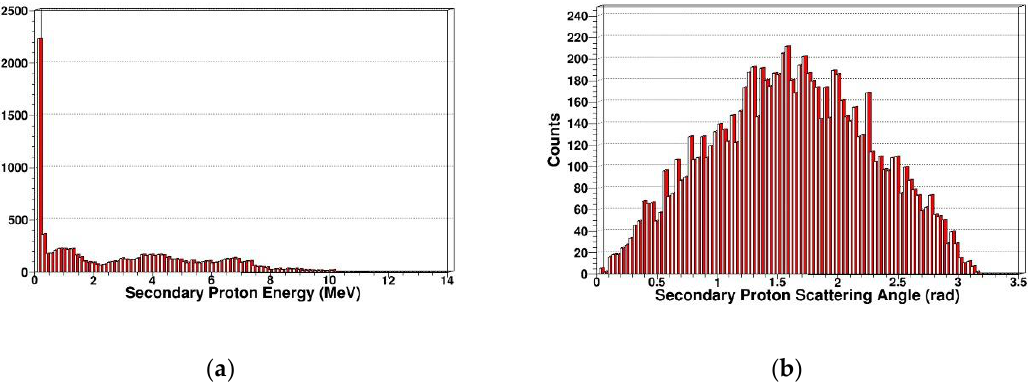
Figure 8. Secondary protons in SDD generated by neutrons: ( a ) Energy spectrum of secondary protons; ( b ) scattering angle distribution of secondary protons.